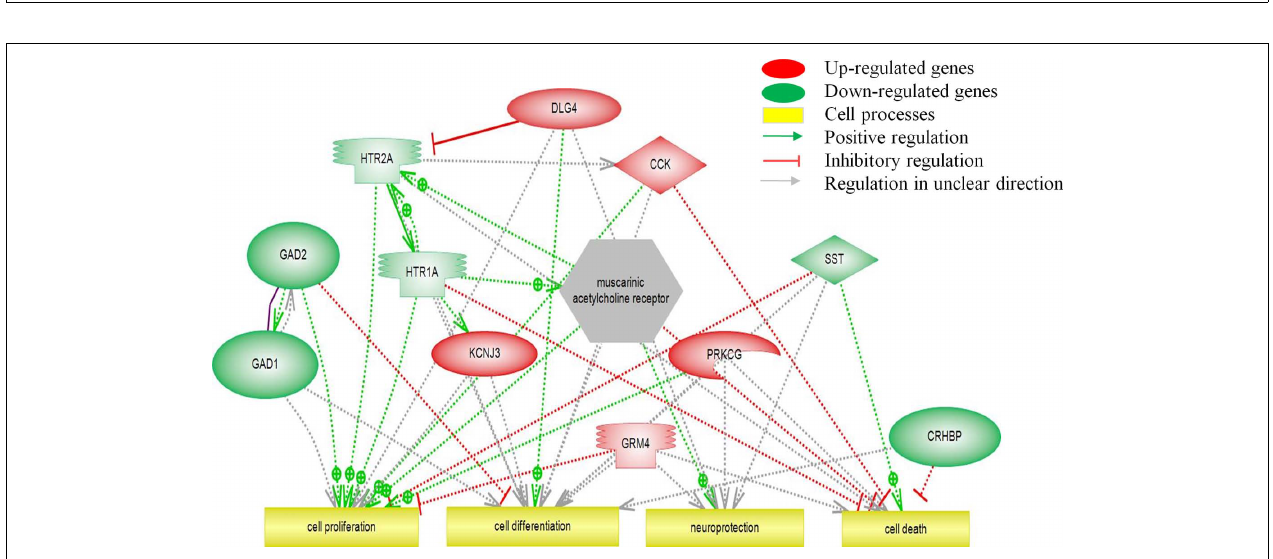
FIGURE 3 | Pathway analysis of transcripts ( p < 0.05) involved in the biological processes of learning and/or memory.